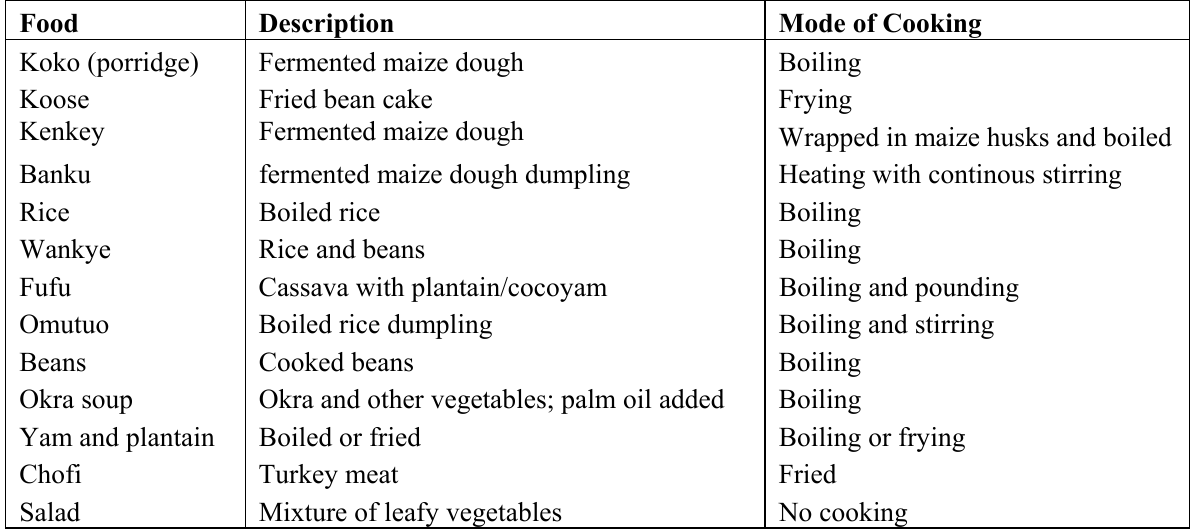
Table 1. Types of ready-to-eat food sold by the vendors.